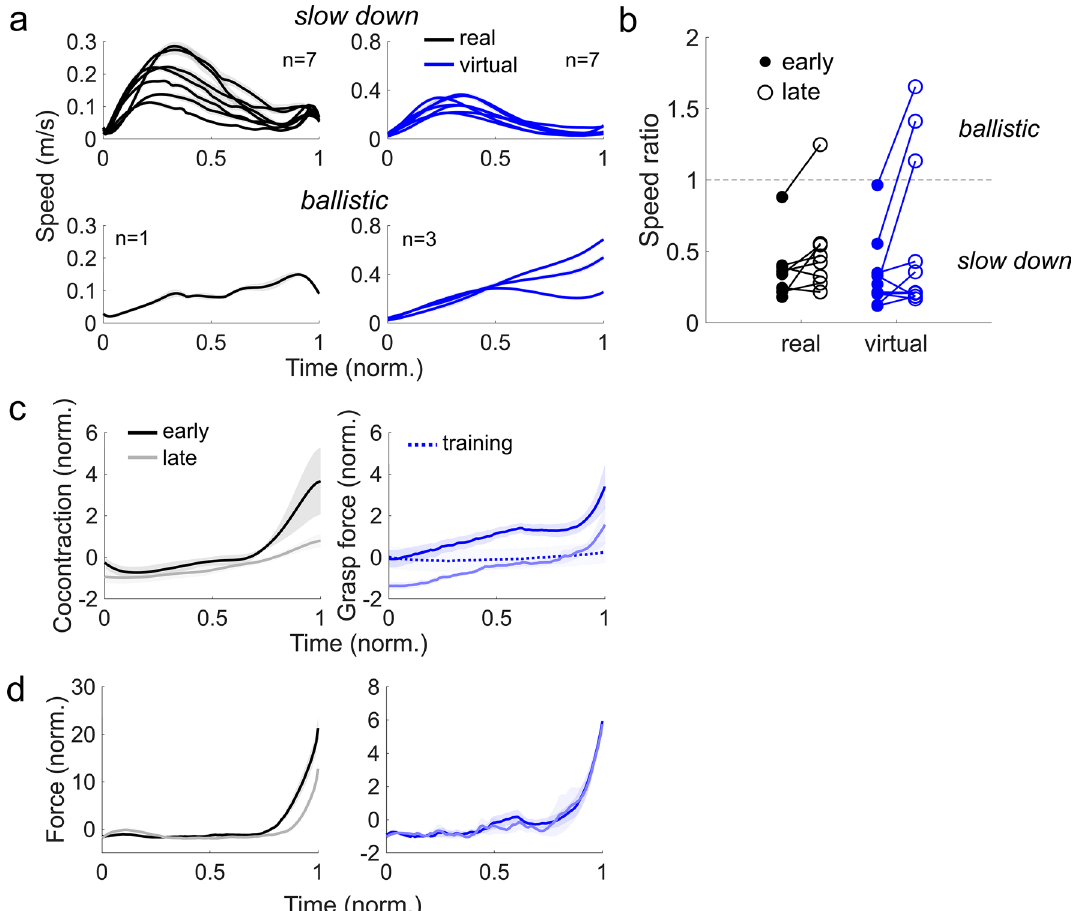
Figure 2. Participants employed either a slow or a ballistic movement when inserting the tool into the fixture. ( a ) Normalized speed time-series averaged in the final phase of the task in the real (black) and virtual insertion (blue). The speed was maximal in the first half of the movement for most participants, who tended to slow down prior to the insertion. Some participants exhibited a ballistic movement where the speed at the end was faster than the first half of the movement. ( b ) Speed ratio in the real and virtual conditions in the early and late stage of the task. Participants exhibiting ballistic movements increased their speed ratio as a function of the trial number, while it remained relatively unchanged for those who slowed down. ( c ) Normalized cocontraction and grasp force as a function of time in the early and late phase. Both increased steadily from the start to the end of the movement, and were lower in the late phase. The grasp force in training trials prior to the insertion task was lower than in the early phase, but higher than the late phase. ( d ) Normalized force as a function of time in the early and late phase of the task. The force was smaller in the late phase in the real task, but remained constant in the virtual